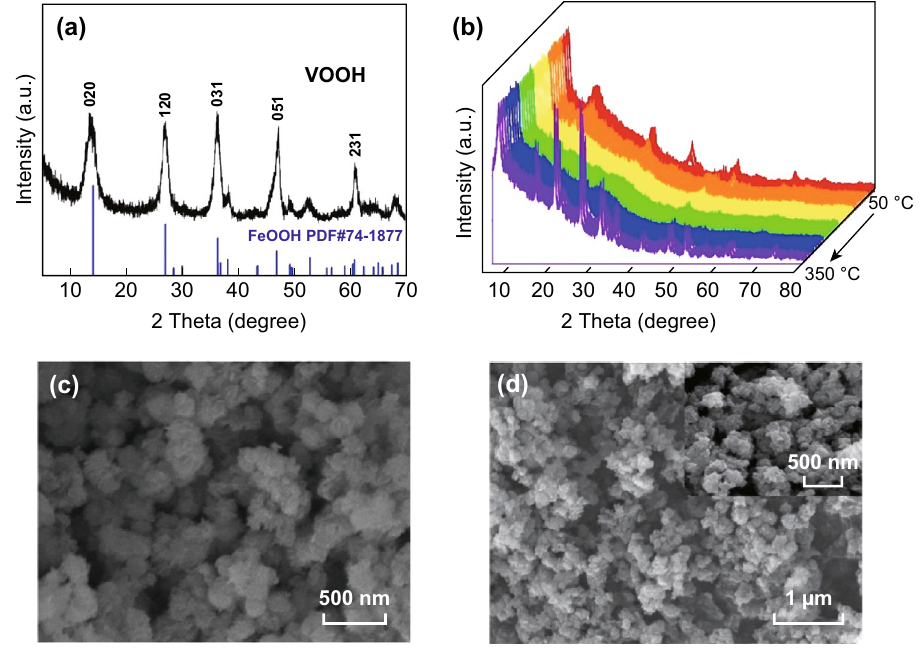
Fig. 1 a XRD pattern of VOOH, b dynamic high-temperature XRD image of VOOH, SEM images of c VOOH and d V 4+ -V 2 O